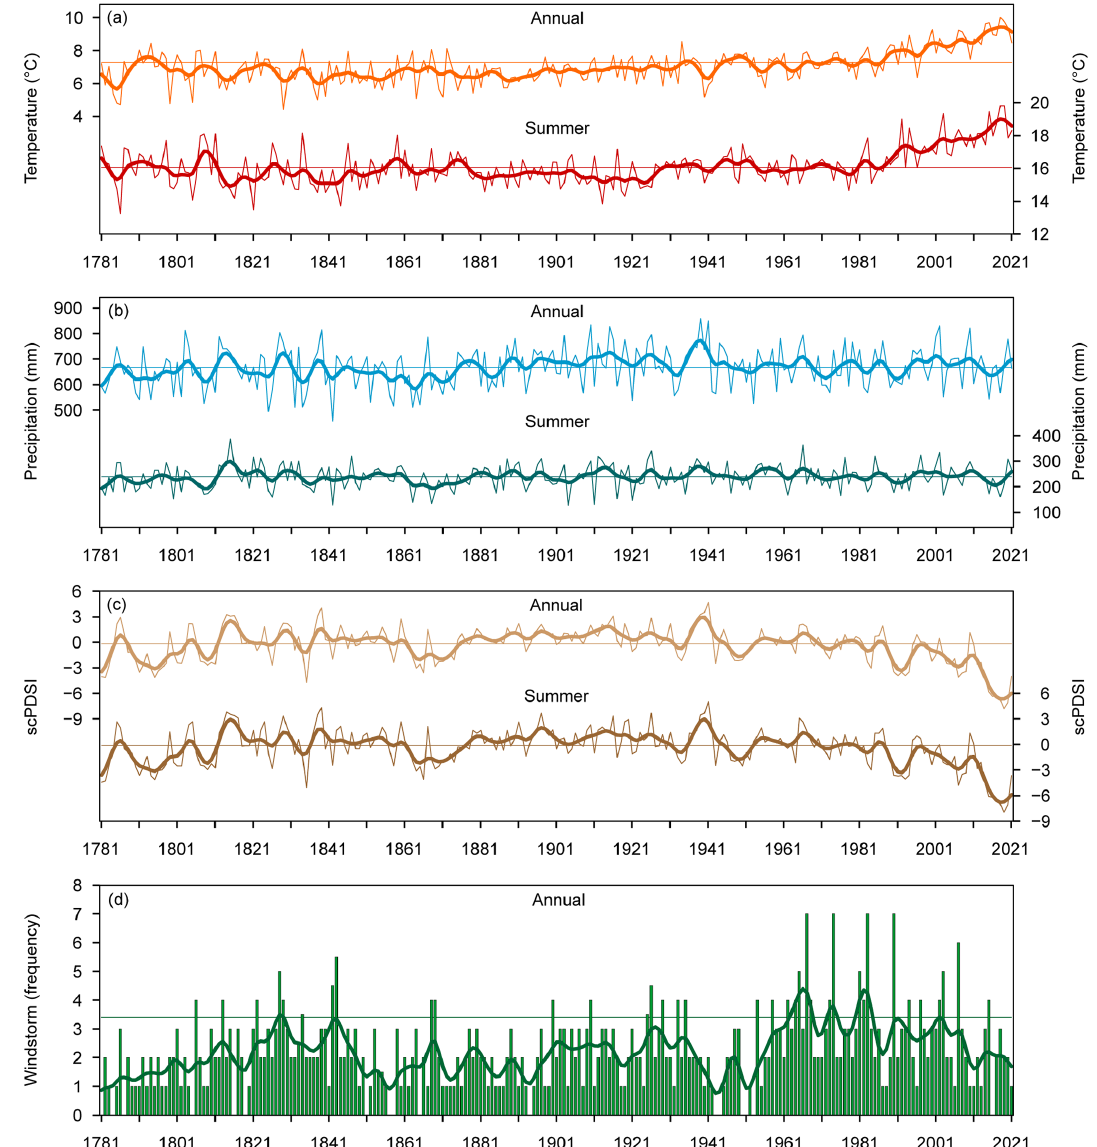
Figure 3. Fluctuations in annual and summer series of (a) mean air temperatures, (b) precipitation totals, (c) scPDSI-3 (summer) and scPDSI- 12 (annual), and (d) severe windstorms for the territory of the Czech Republic during the 1781–2021 period. The values are smoothed by a 10-year Gaussian filter (bold line) and complemented by horizontal lines corresponding to related means of the 1961–1990 period.